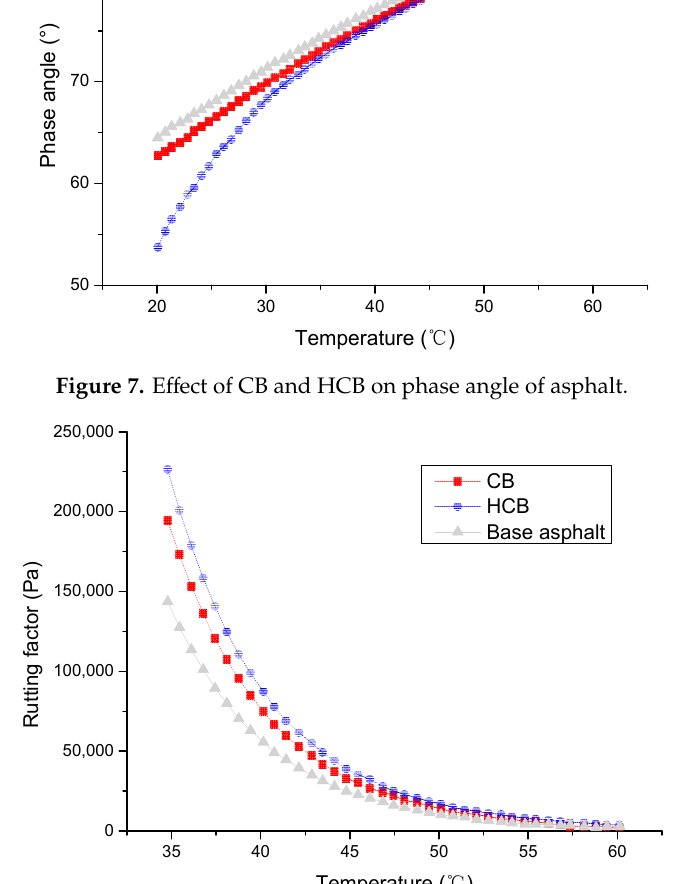
Figure 8. Effect of CB and HCB on asphalt rutting factor.